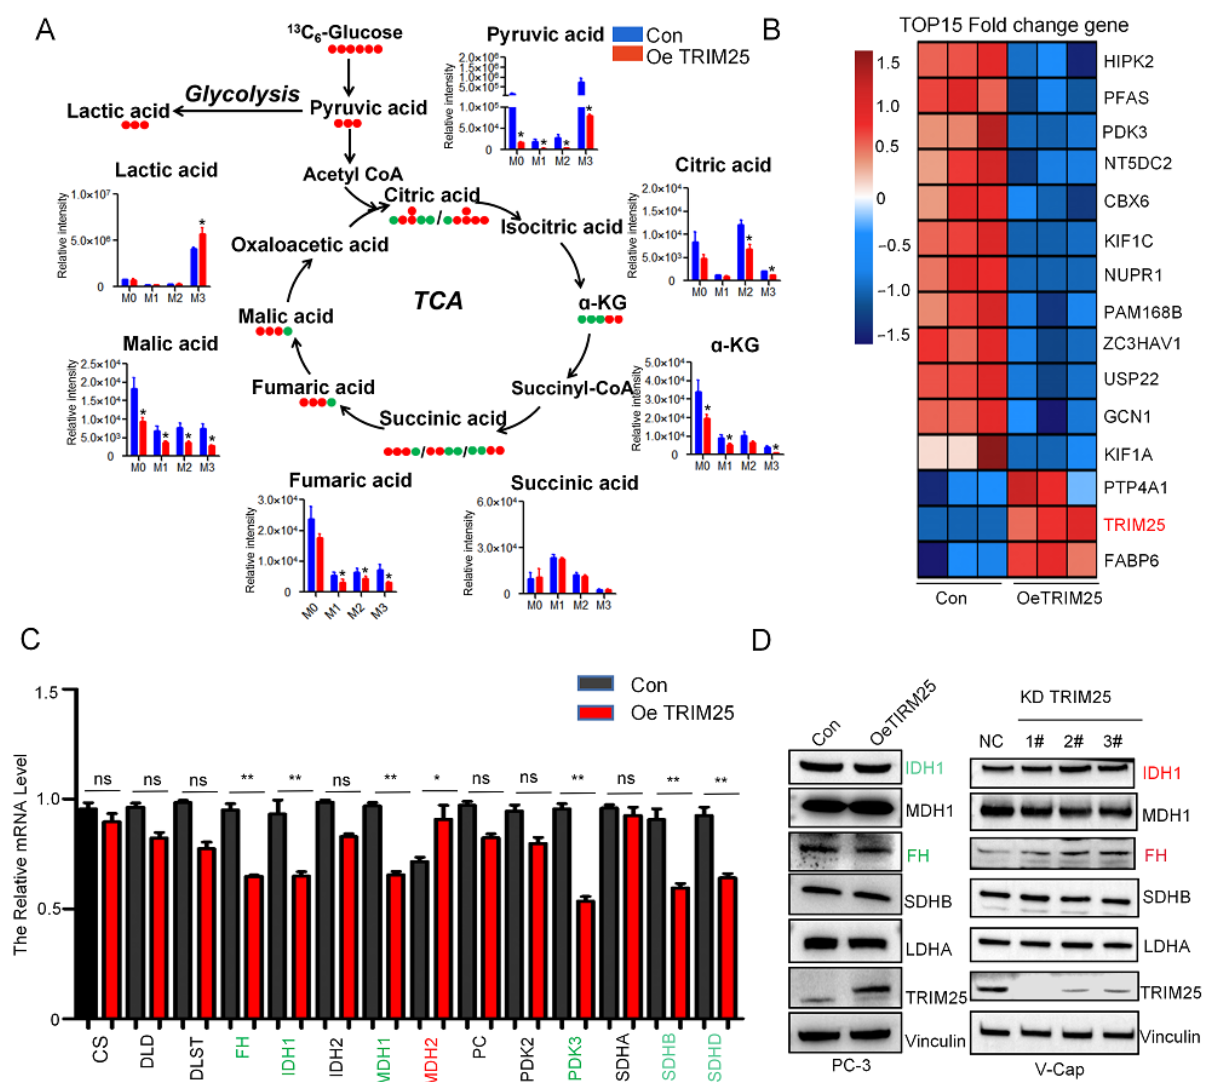
Figure 3. TRIM25 enhances glycolytic flux by downregulating the expression level of TCA cycle-related enzymes. ( A ) GC – MS detection of metabolic flux changes in glucose- 13 C6-labeled TRIM25 overexpression PC3 cells. M0, unlabeled mass of isotopologue; Mn, native metabolite mass (M) plus number of isotopically labeled carbons (n). Error bars show the mean ± SEM of three in- dependent replicates or more. ns, not significant; *, p < 0.05; **, p < 0.01, as determined by unpaired t -tests. ( B ) Heat map plot with the top 15 most significant differential genes in transcriptomics. ( C ) The mRNA expression of TCA-related genes in TRIM25 overexpression PCa cells. *, p < 0.05; **, p < 0.01, as determined by unpaired t-tests; ns, not significant. ( D ) The protein expression of TCA-related enzymes in PCa cells.